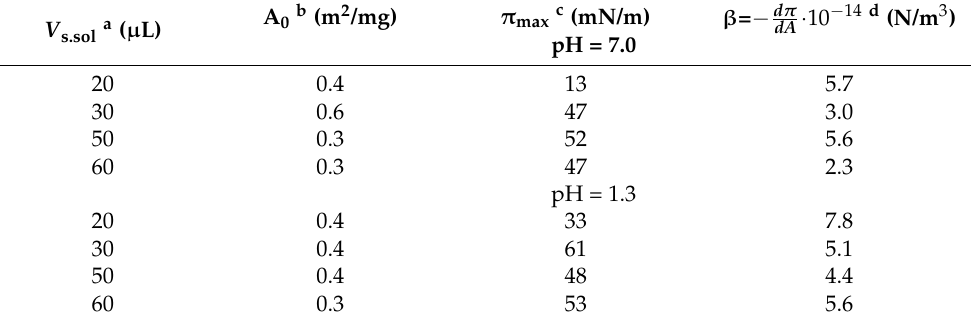
Table 3. Characteristics of Langmuir monolayers of block copolymer PNIPAAm–Ge(C 6 F 5 ) 2 –PFMA at pH = 7.0 and pH = 1.3 obtained from isotherms of surface pressure π = f( A ) spread with chloro-